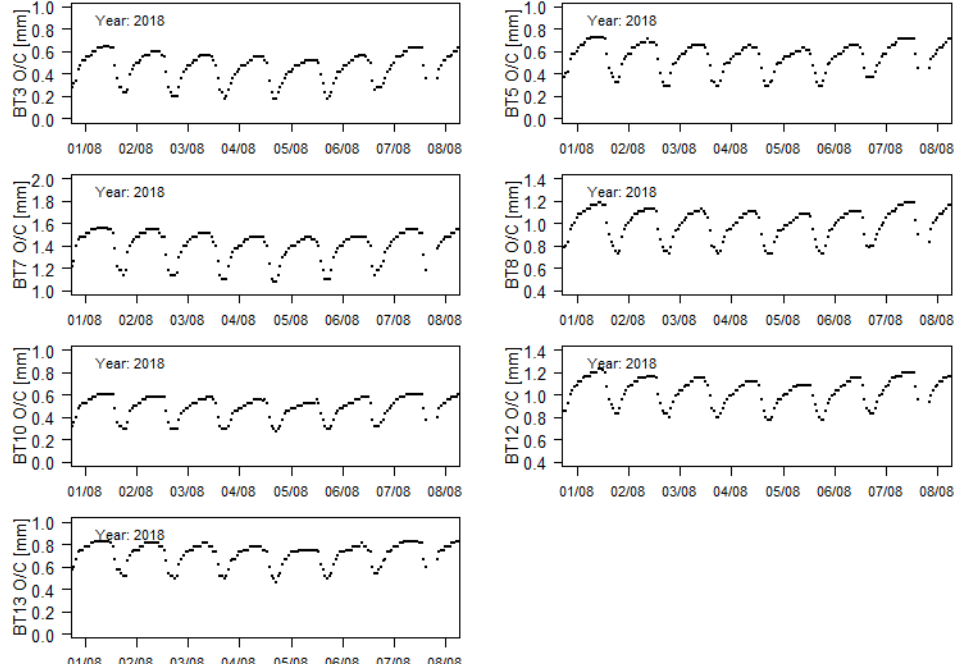
Figure 8. Time series of the relative movements between blocks measured between the 1st and the 8th of August 2018.